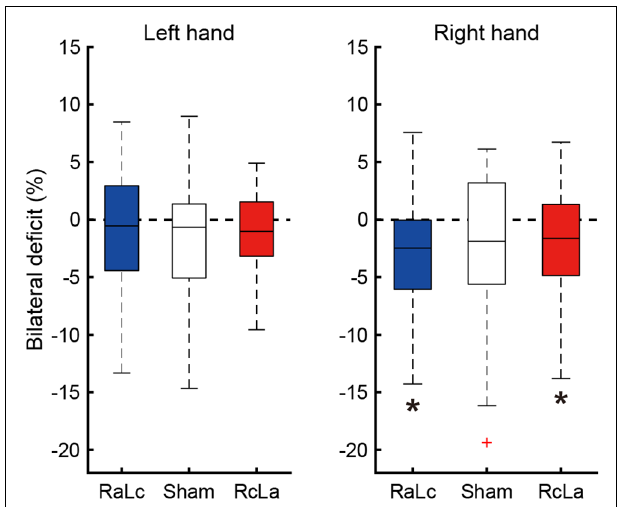
FIGURE 3 | Bilateral deficit (BLD) in handgrip force following the stimulation condition. The horizontal line in the boxes indicates the median, the boxes extend to the 25th and 75th percentiles, the whiskers extend to the extreme values, and the cross represents the outlier. Negative values indicate less bimanual handgrip force compared with that in unimanual handgrip force. RaLc, the anode on the right primary motor cortex (M1) and the cathode on the left M1; RcLa, the anode on the left M1 and cathode on the right M1. * p < 0.05.